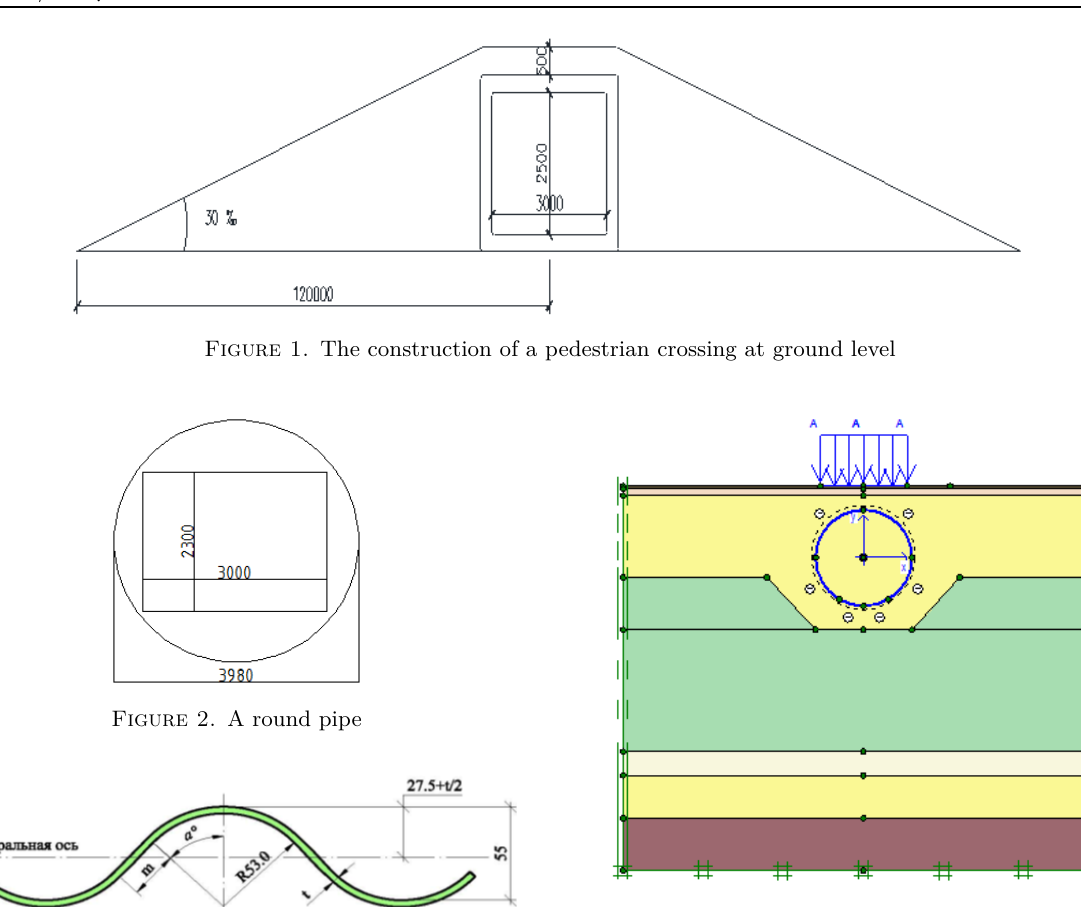
Figure 4. Design